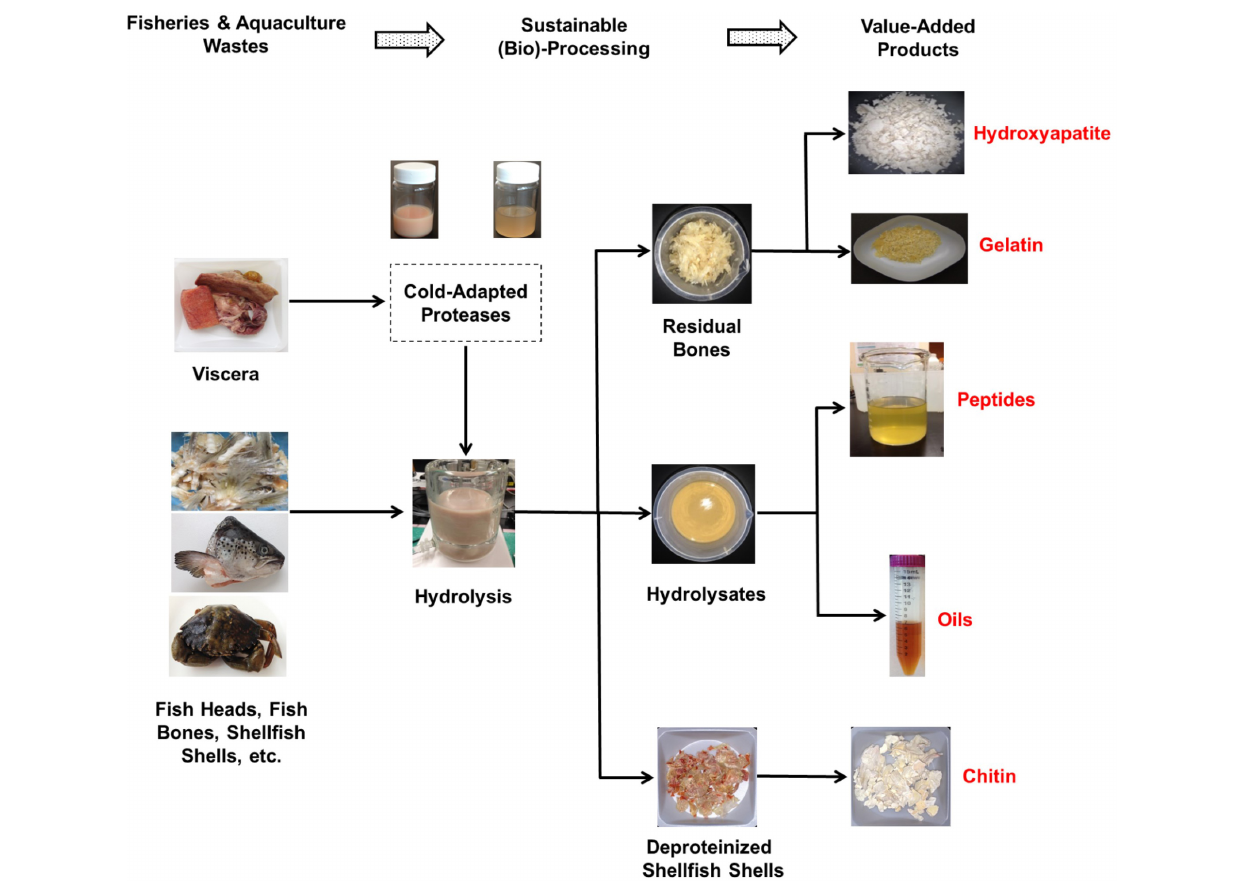
FIGURE 1 | A closed-loop, cost-effective, and environmentally sustainable process for upcycling fisheries and aquaculture wastes using fish- and/or shellfish-derived cold-adapted